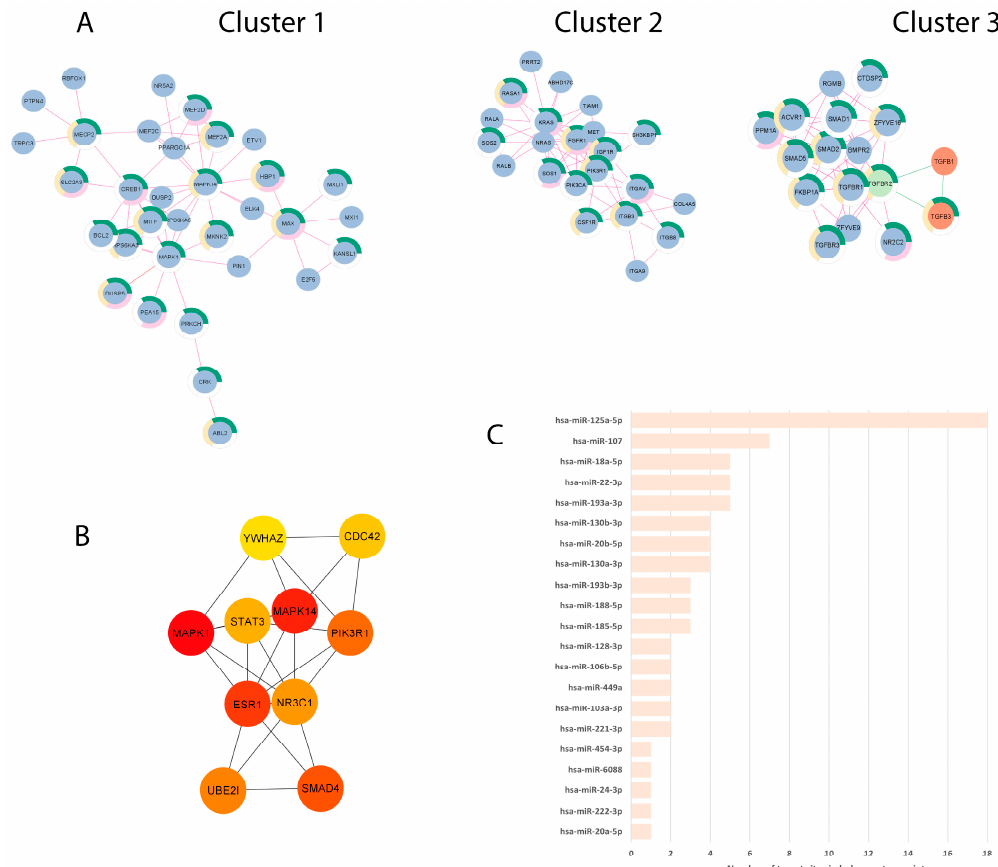
Figure 4. PPI network analysis identified top 3 clusters and 10 hub genes dysregulated by both T. vaginalis and P. bivia . ( A ) Top three main clusters identified by Cytoscape: Blue and orange circles (nodes) depict putatively down- and up-regulated proteins, respectively. TGFBR2 (green node) had its expression predicted in both directions. Edges represent interactions of proteins estimated from up-regulated (pink lines) or down-regulated (green lines) miRNAs data sets. Cluster 1: 33 nodes and 55 edges, cluster 2: 22 nodes and 58 edges, and cluster 3: 17 nodes and 48 edges (proteins are shown in Supplementary Table S5). Donut semicircles show proteins enriched in terms related to the female reproductive system (green), female reproductive gland (pink), and internal female genital organs (yellow) (TISSUES database). ( B ) PPI between the top-10 hub genes identified from the merged network, determined by CytoHubba according to MCC analysis. Colors depict centrality score from higher (red) to lower (yellow) values (values are shown in Table 1). ( C ) EV-miRNAs targeting the 10 hub genes, plotted according to the total number of 3 ′ UTR target sites including splicing variants (respective expression values are shown in Supplementary Table S7).